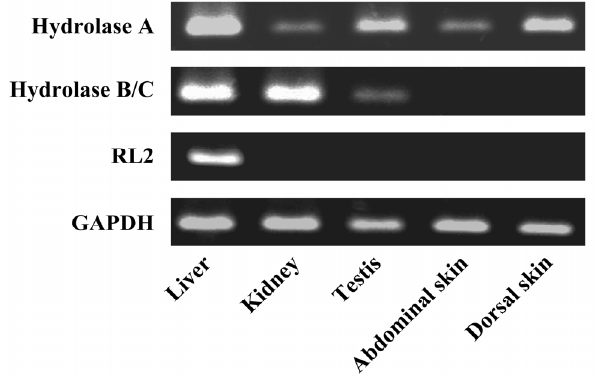
Figure 3. The mRNA expression levels of rat CES1 isozymes in rat liver, kidney, testis and skin. The gene expression levels of rat CES1 isozymes and GAPDH were assessed